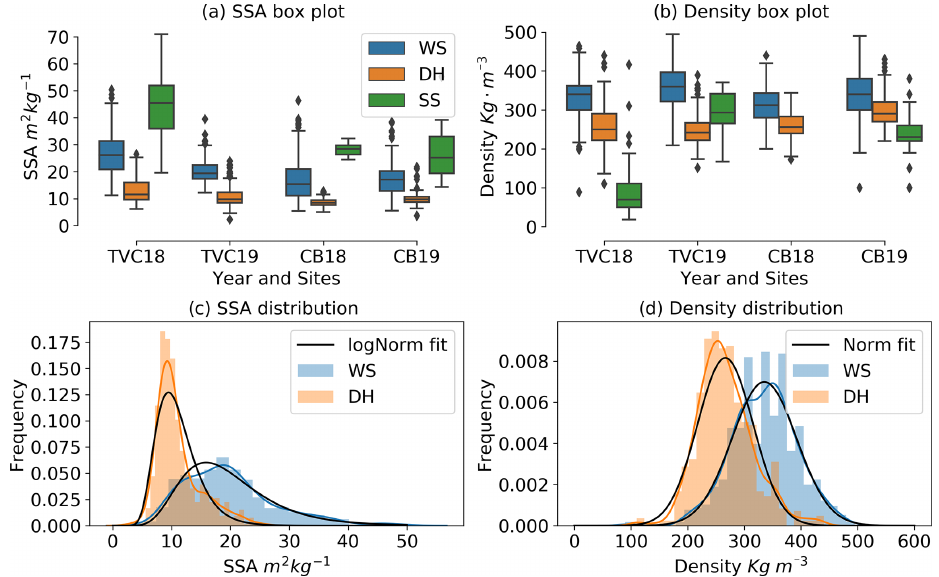
Figure 5. SSA and density variability of surface snow (SS), wind slab (WS) and depth hoar (DH) for the two studied sites (TVC and CB) and different dates (see Table 5). In panel (c) the best log-normal fit distribution is shown in black; (d) same as panel (c) but for the normal fit distribution. In panels (c) and (d) , the kernel density estimates (KDEs) of the histogram of each layer are also shown (in color).